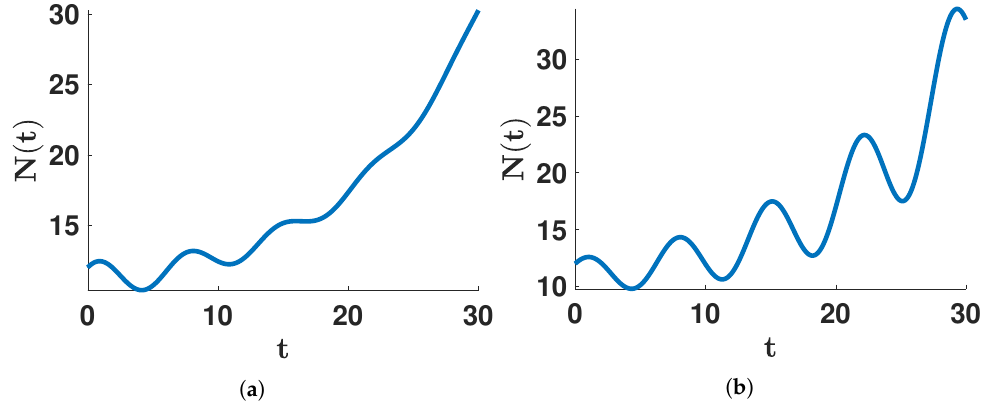
Figure 3. We plot an exponentially growing function with ( a ) damped oscillations and ( b ) ampli- fied